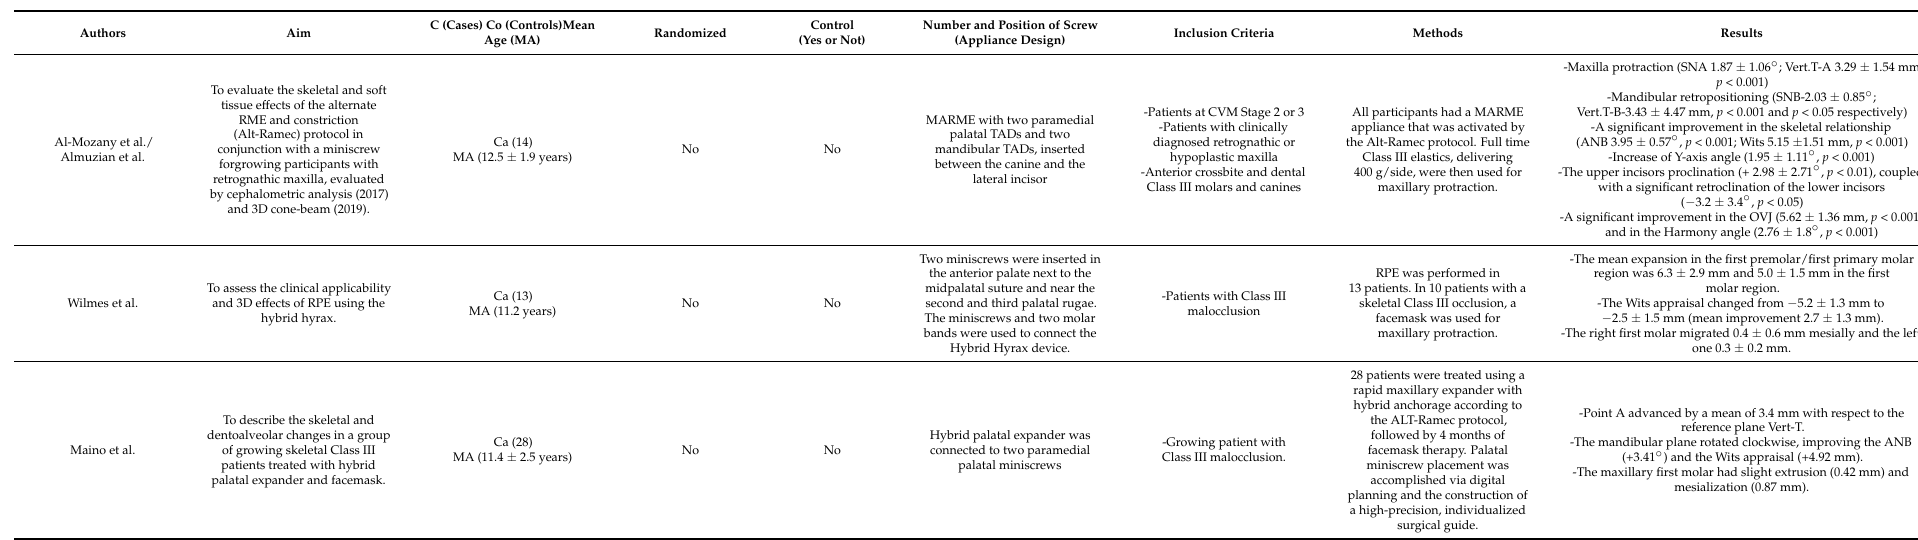
Table 2. Studies involved in the qualitative